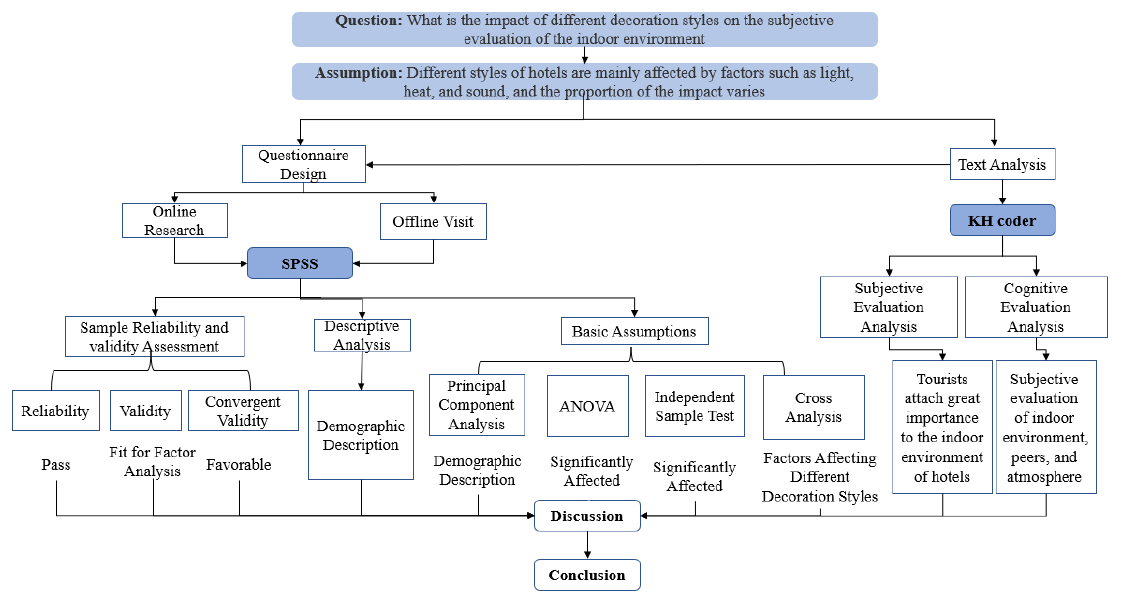
Figure 1. The technical route framework for